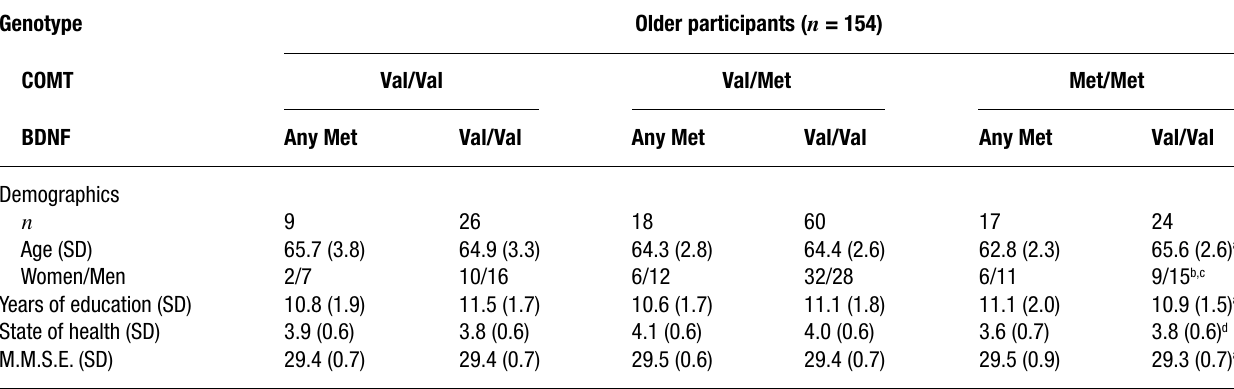
Table 2. Between-genotype comparisons of demographic data in the sample of older adults (age range = 60–70 years). Genotype Older participants ( n = 154)